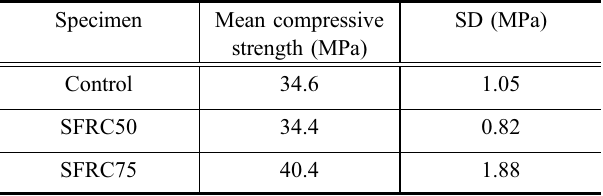
Table 1 Cube compressive strengths of concrete